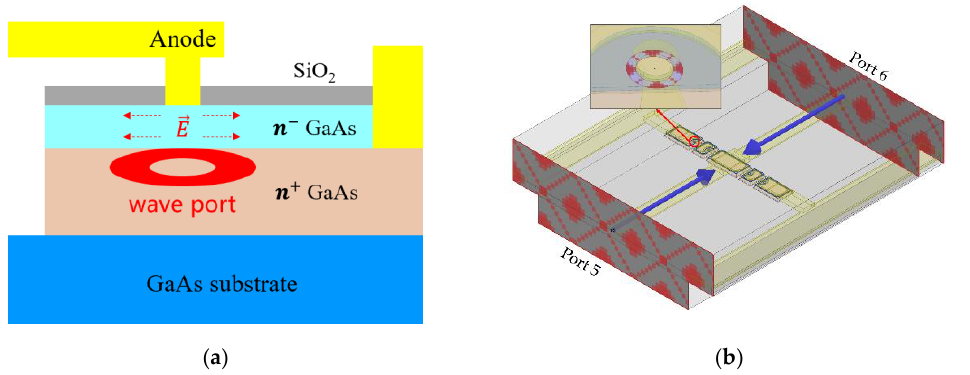
Figure 2. Schematic diagram of ( a ) wave port configuration of diode anode junction and ( b ) setup for high-frequency 3D EM simulations.